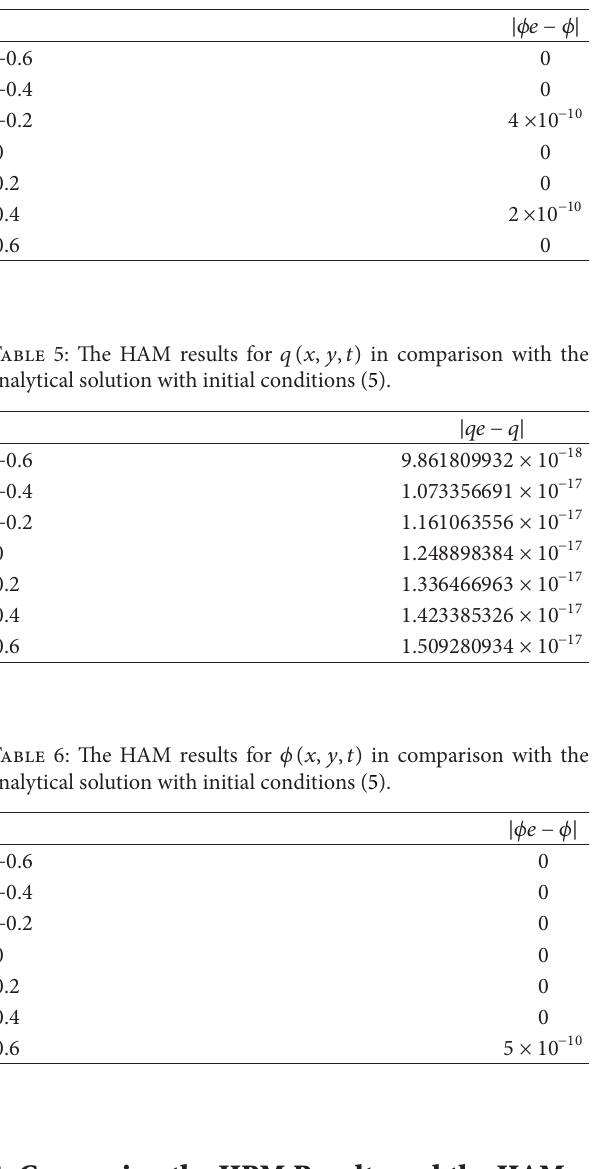
Table 4: The HAM results for 𝜙(𝑥,𝑦, 𝑡) in comparison with the analytical solution with initial conditions (3).